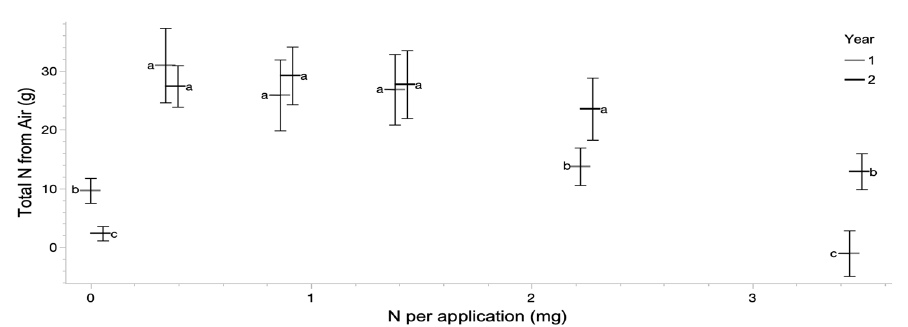
Figure 3. Mean and 95% confidence intervals for calculated nitrogen inputs from the atmosphere to each individual plant based on isotope mixing model and total nitrogen uptake of each replicate. Connecting letters represent Tukey’s HSD for each Harvest period independently.